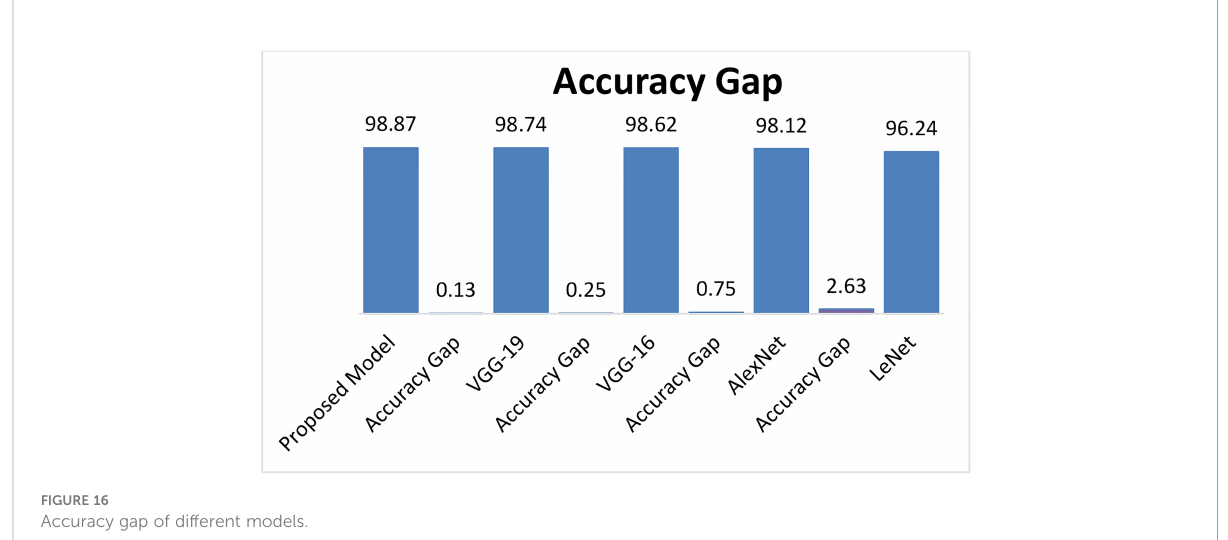
FIGURE 16 Accuracy gap of different models.